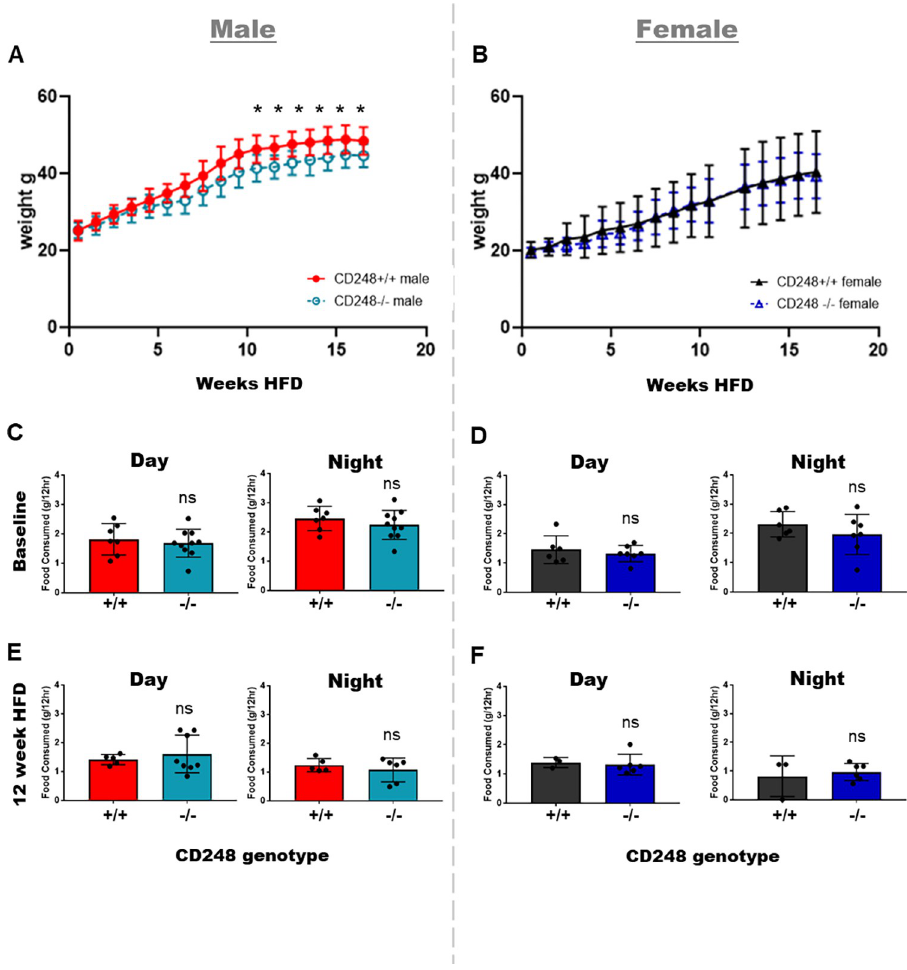
Fig 1. Weight gain ± SD over 16 weeks of high fat diet in (A) males and (B) females. Food intake ± SD at baseline (C) day and (D) night. Food intake over 12 hours after 12 weeks of high fat diet during the (E) day and (F) night. Body weight data over time were analysed for significant differences by t-test. Food intake was analysed by t-test. In all graphs: Cd248 +/+ males (red), Cd248 -/- males (cyan), Cd248 +/+ females (black), Cd248 -/- females (blue). Significant * p �